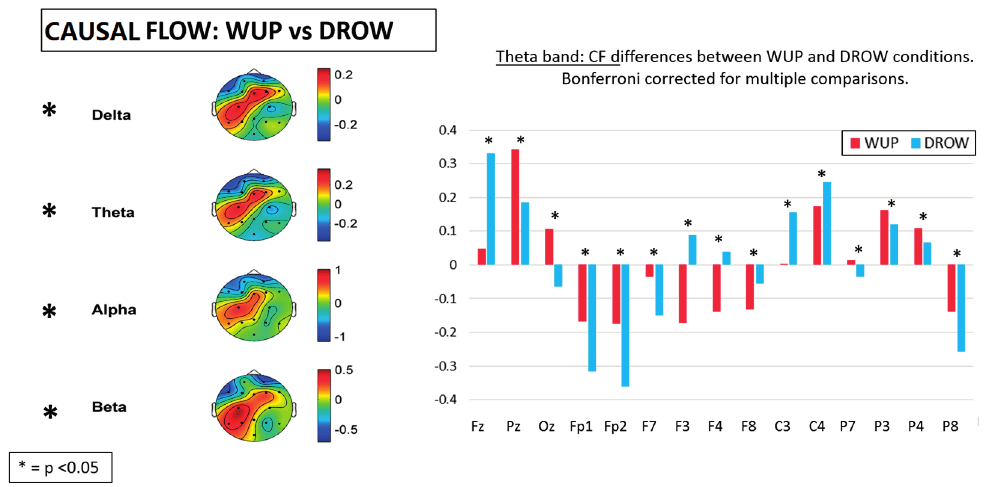
Figure 10. Differences of Causal Flow (CF) between the WUP and DROWSY